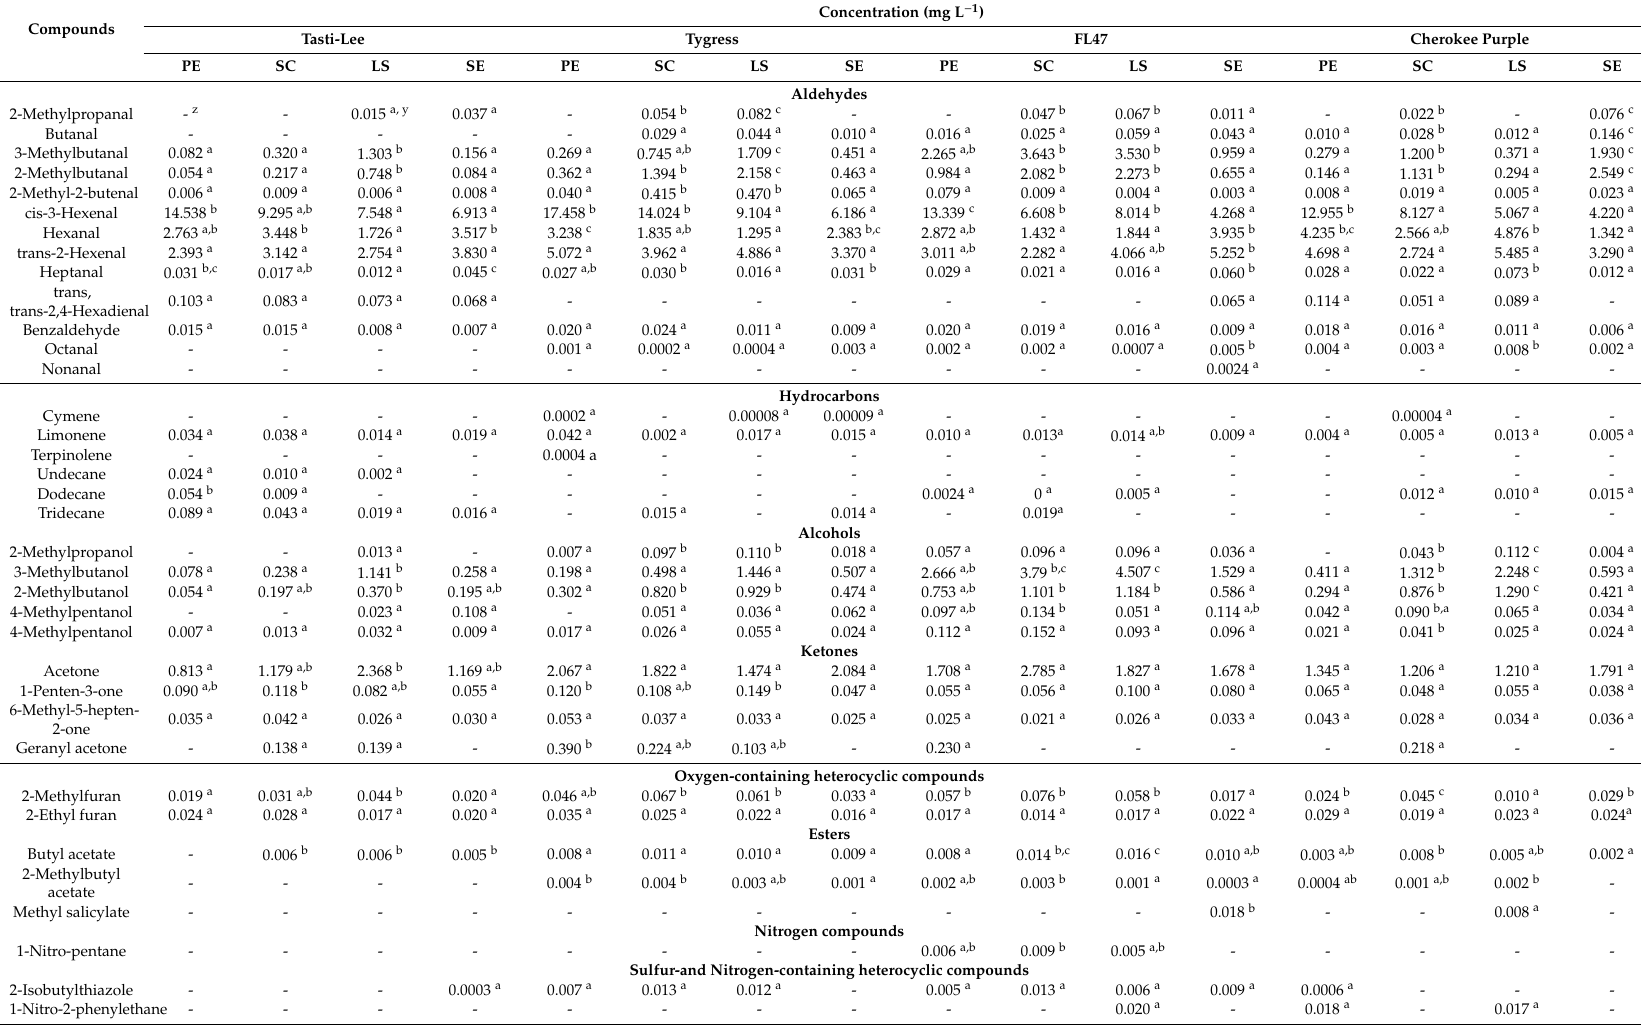
Table 3. Concentrations of volatile compounds identified in di ff erent tissues of tomato